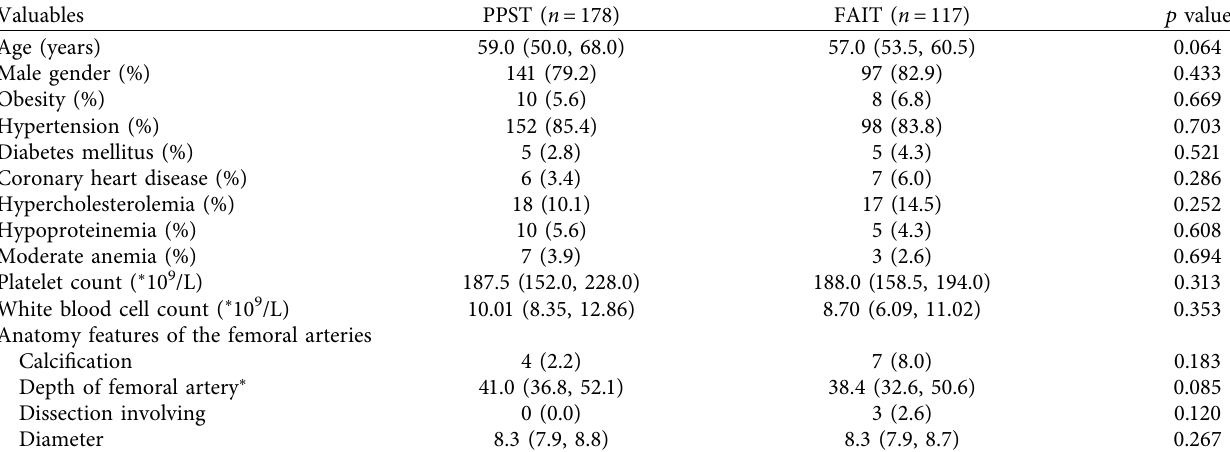
Table 1: Preoperative data on the two patient groups.